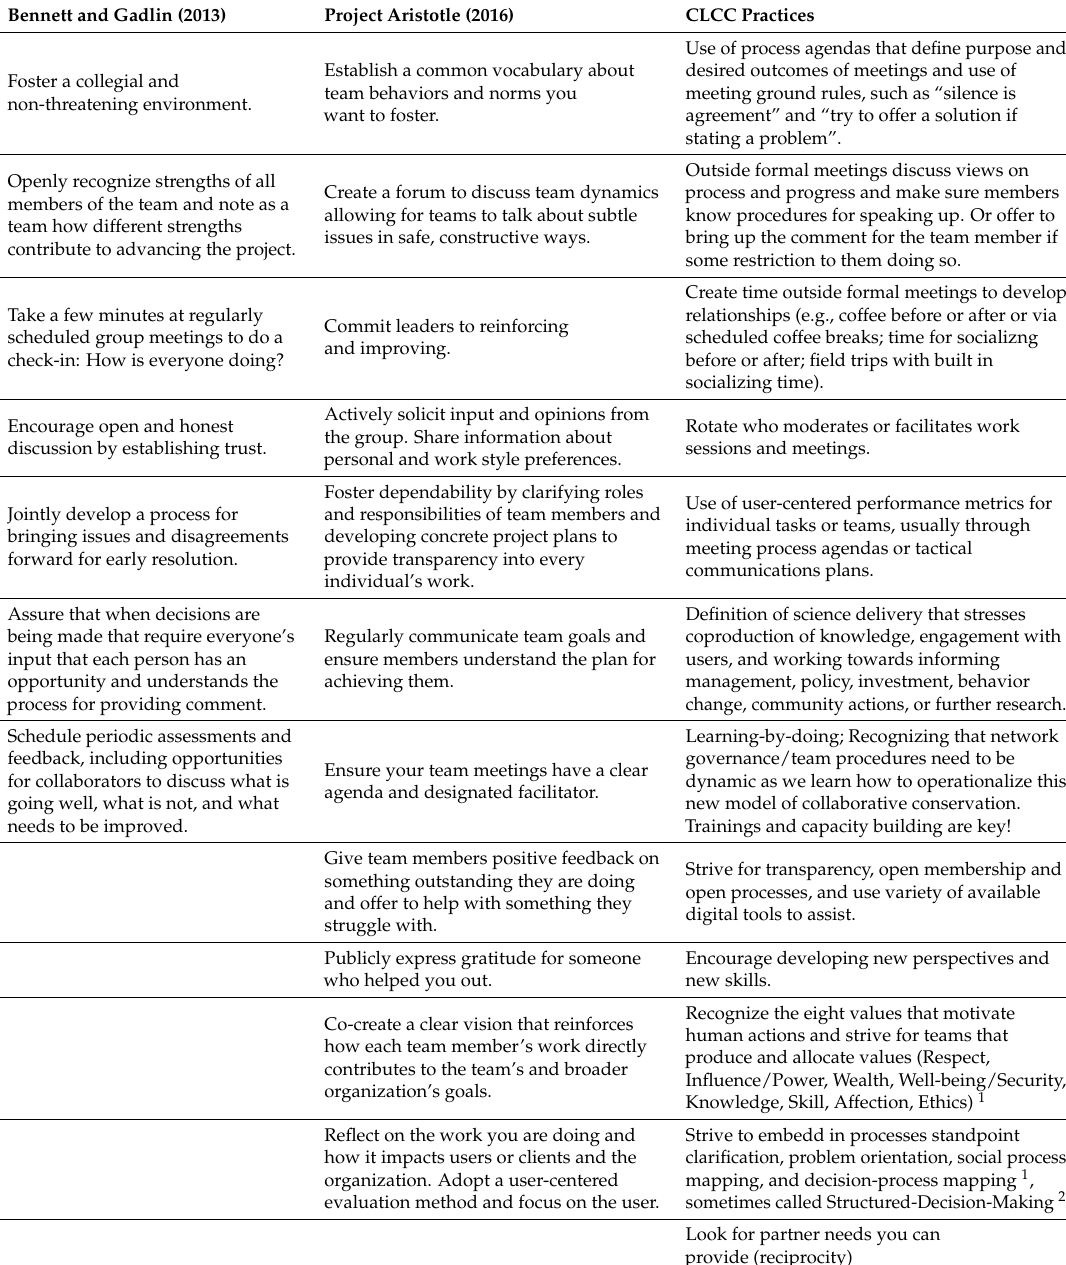
Table 3. Ways to Strengthen Team Relationships and Dynamics (compiled from Bennett and Gadlin (2013), Project Aristotle, and author perspectives of Caribbean Landscape Conservation Cooperative (CLCC)